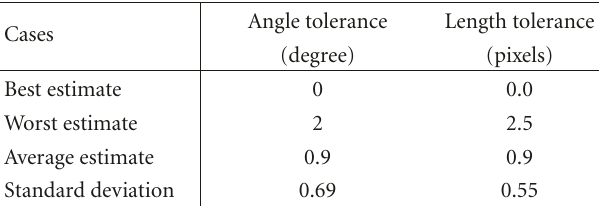
Table 2: Experimental results of our algorithm on 80 degraded standard images (256 × 256) with additive noise with zero mean and 0 . 01 to 0 . 6 variance (SNR > 22 dB).